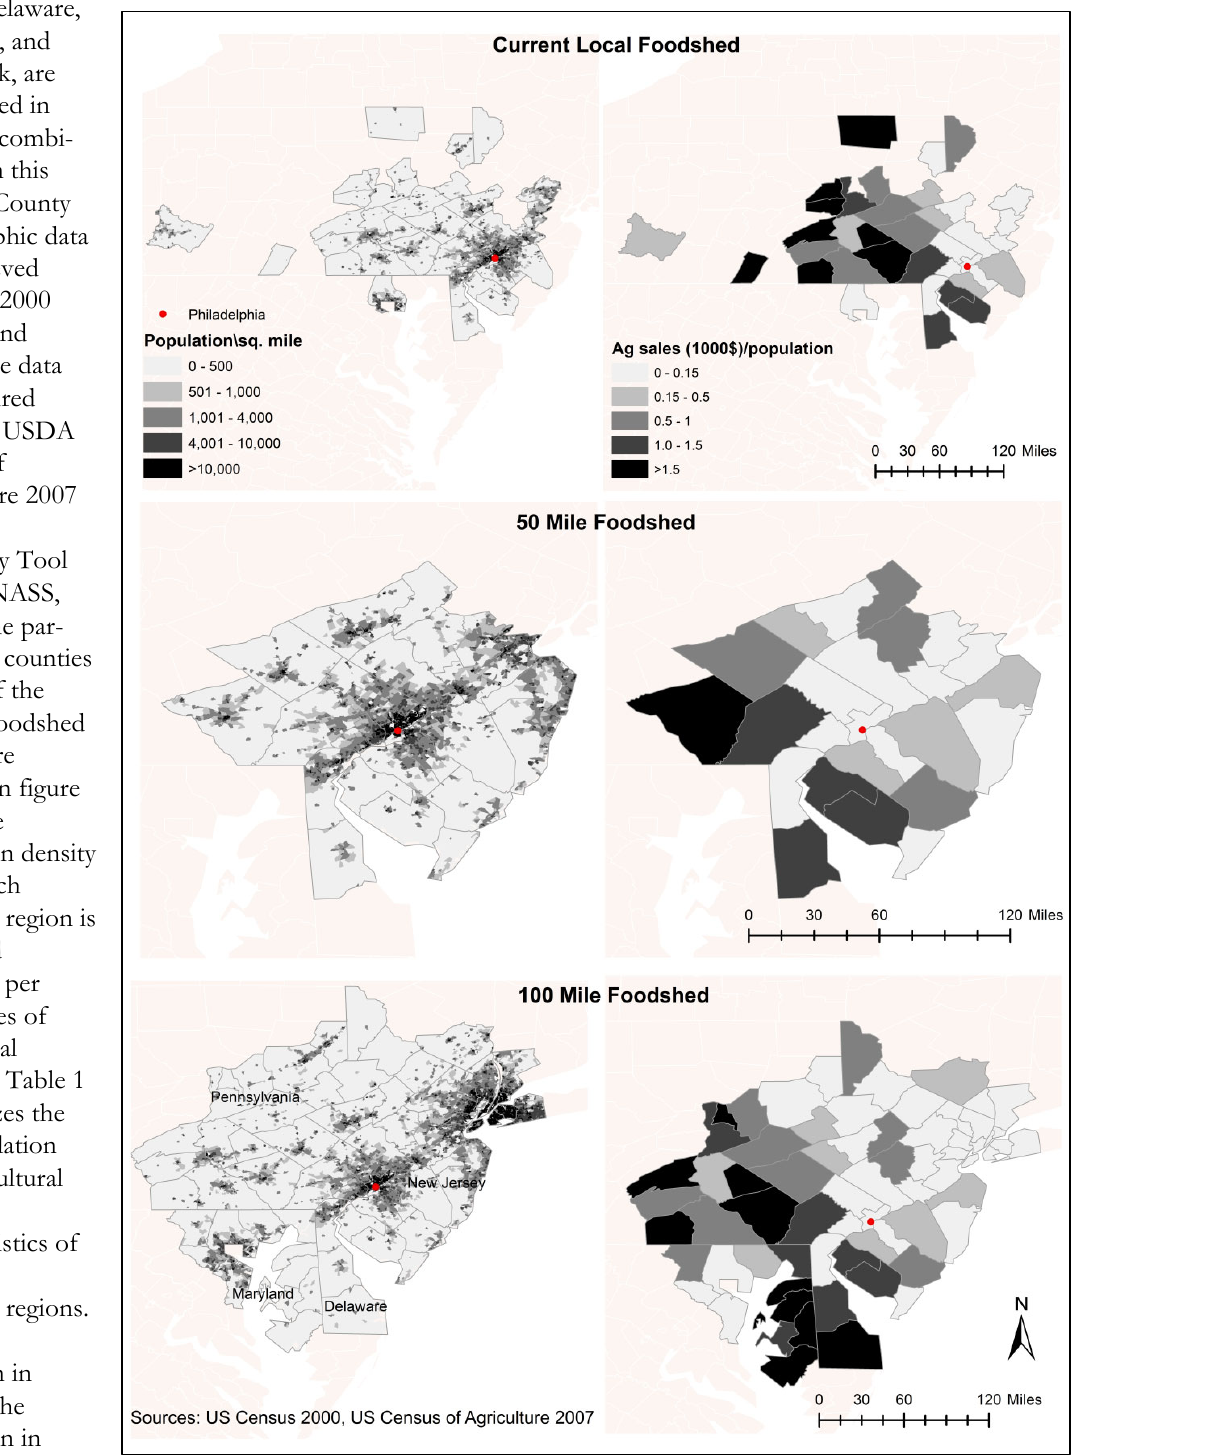
Figure 2. Three Defined Foodshed Regions On the left: Population density in the study area. On the right: Per capita sales of agricultural